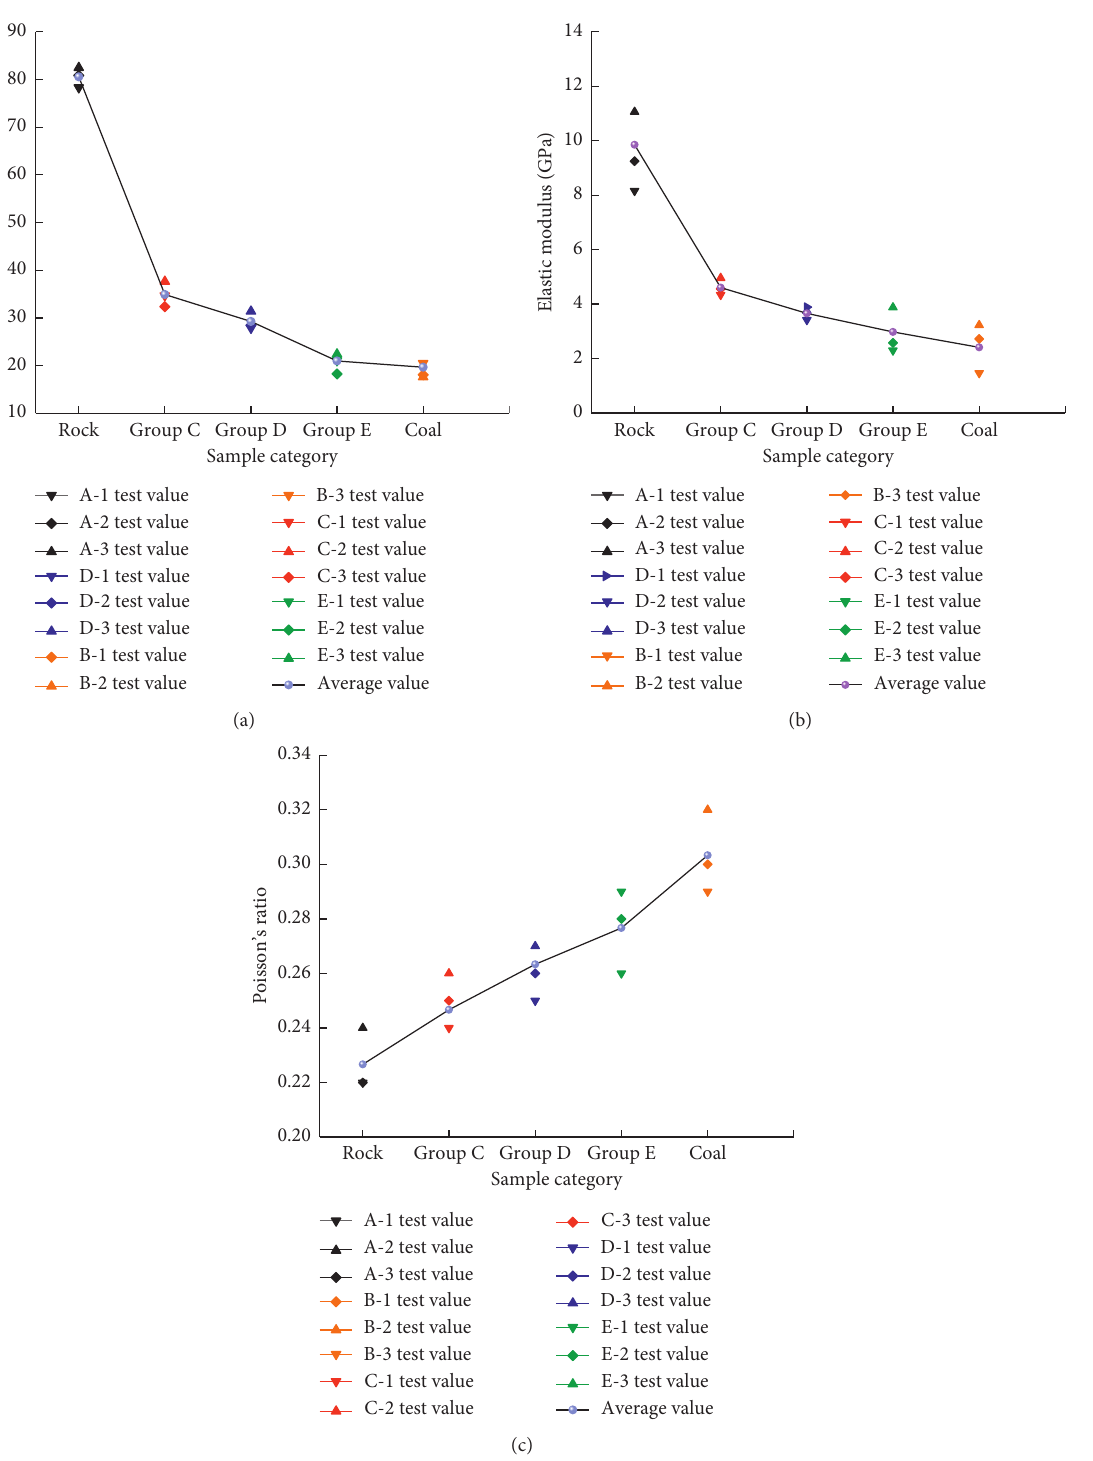
Figure 5: Test results of mechanical parameters of each group of samples: (a) compressive strength, (b) elastic modulus, and (c) Poisson’s